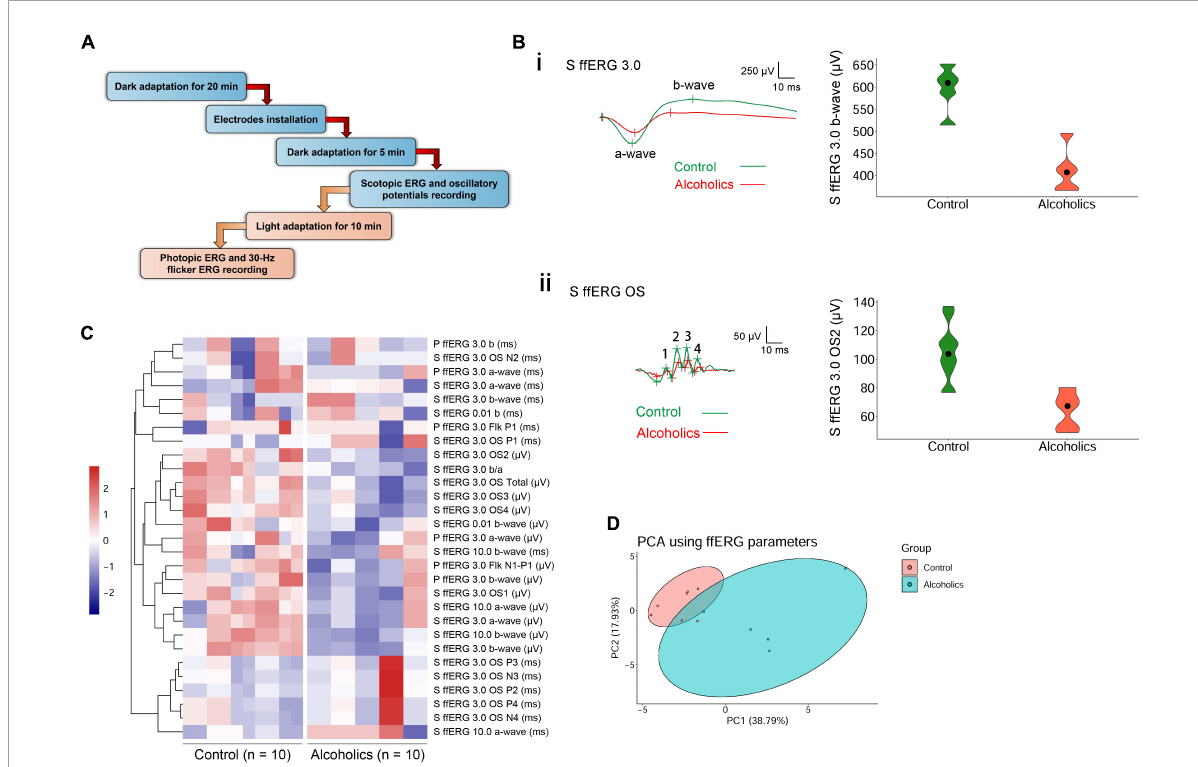
FIGURE1 ffERG shows significant differences between alcoholics and control individuals. (A) Experimental procedures are summarized in the diagram. (B) Typical ffERG waveforms in normal and alcohol addictive individuals are presented, and quantification of representative parameters are displayed in the form of violin plots. (i) Scotopic ERG 3.0 waveforms and the quantification and distribution of b-wave amplitudes are shown. (ii) Scotopic ERG 3.0 oscillatory potential wavelets and the quantification and distribution of OS2 amplitudes are shown. In scotopic ERG oscillatory potentials, the first peak was identified as OP1. OPs 2–4 following OP1 were labeled in sequential order. The inserts give scale. (C) Heatmap reveals many reduced amplitudes in alcohol addicts by ffERG measurements. Correlated parameters are clustered. (D) PCA combining data from ffERG parameters shows variation between the normal and alcoholics across PC1 and PC2. S, scotopic; P, photopic; OS: oscillatory; Flk: